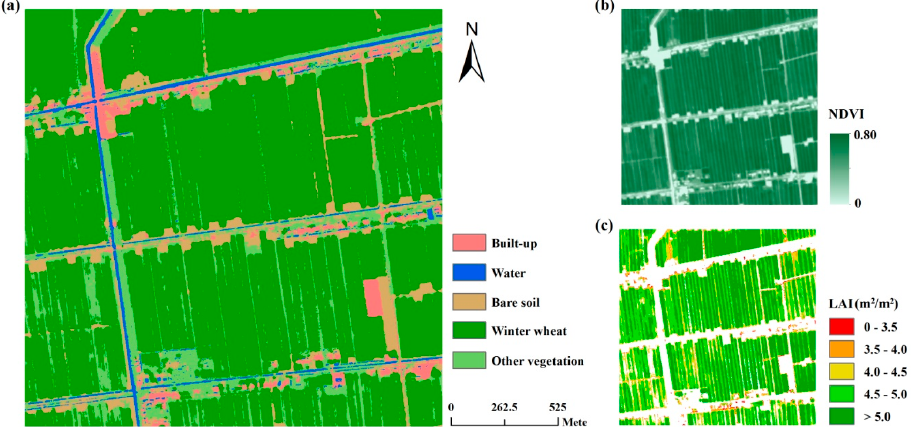
Figure 4. Mapping of leaf area index (LAI) from the GF-1 satellite image: ( a ) the land use map of the study area; ( b ) the NDVI image derived from the GF-1 image; and ( c ) the LAI map generated from the power function relating LAI to NDVI (Table